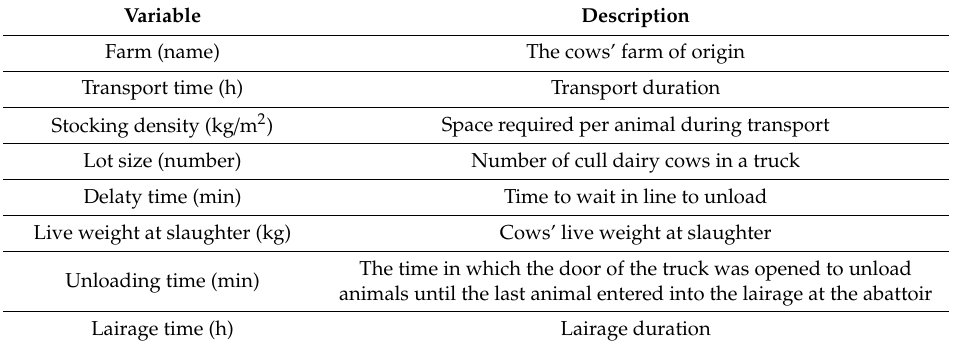
Table 1. Variables registered on the transport conditions, unloading and lairage of the cull dairy